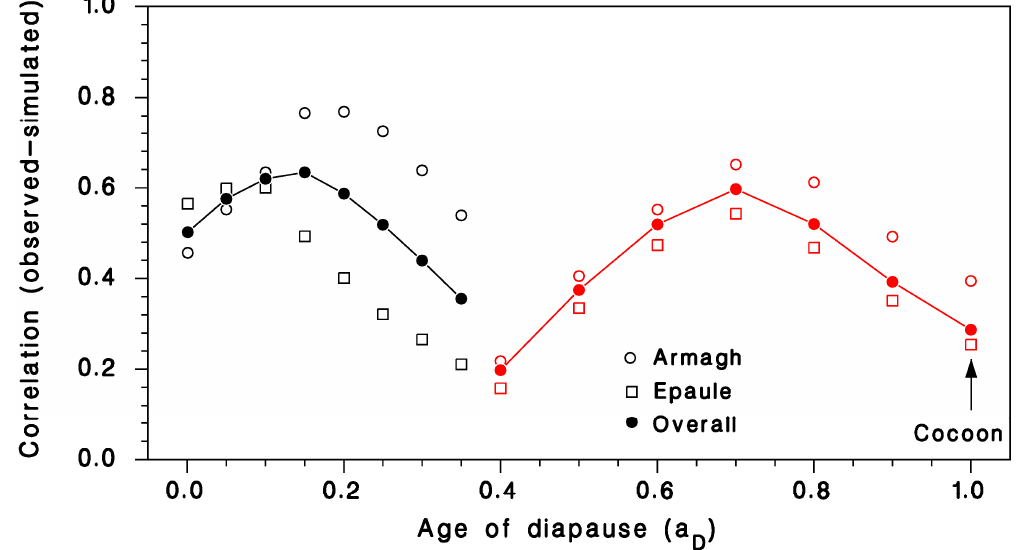
Figure 5. Sensitivity of model output to variation in the age of entry into diapause, expressed as a correlation between observed and simulated oviposition of Tranosema rostrale on larvae of SBW. Observations from Armagh and Epaule, in odd years between 1999 and 2017. Black: Diapause Scenario 1 (on the tree); Red: Diapause Scenario 2 (on the ground). Age 0 is newly laid egg, age 1 is pupa in its cocoon. Scenario 1 optimum: a D = 0.15; Scenario 2: a D = 0.7.